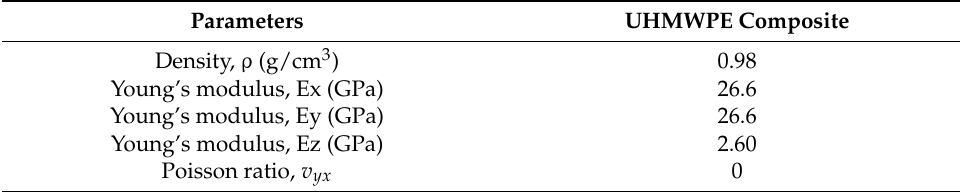
Table 4. MCD material model parameters for the UHMWPE